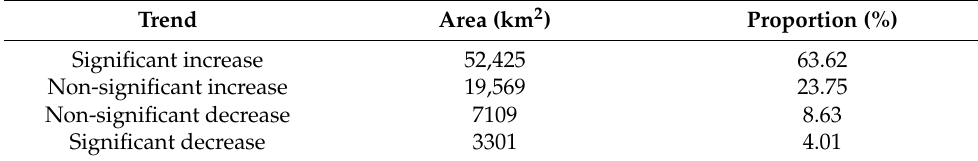
Table 2. Area and proportion of different vegetation-cover changes in